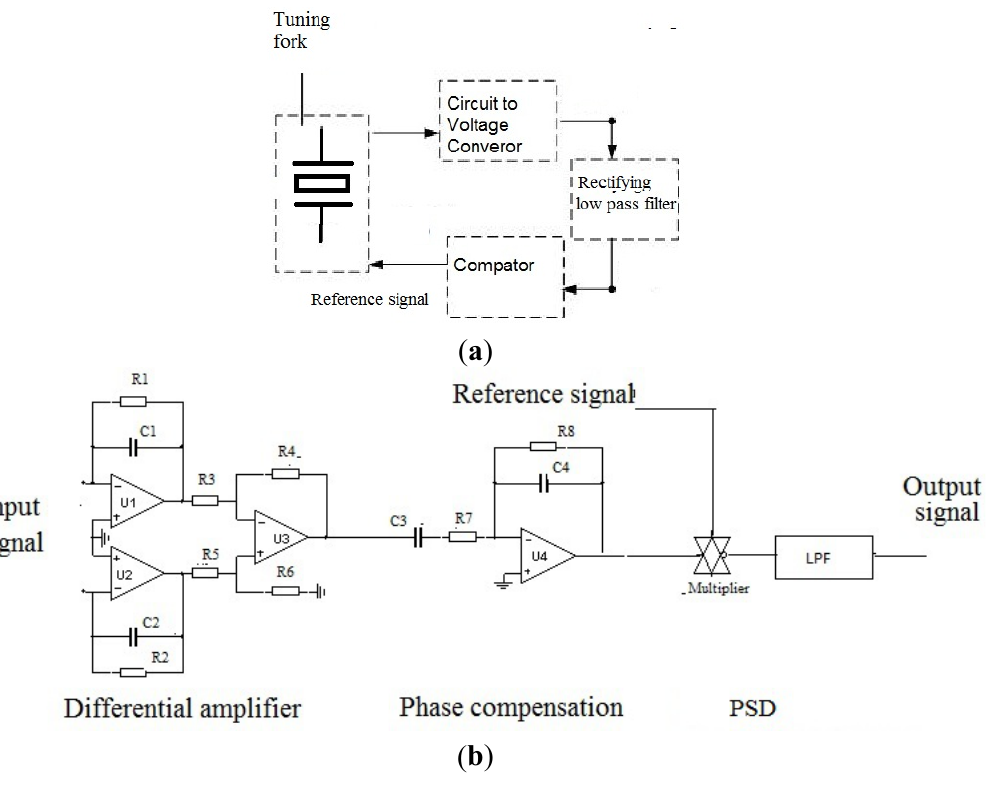
Figure 12. Signal detection process; ( a ) Drive part and ( b ) Detect